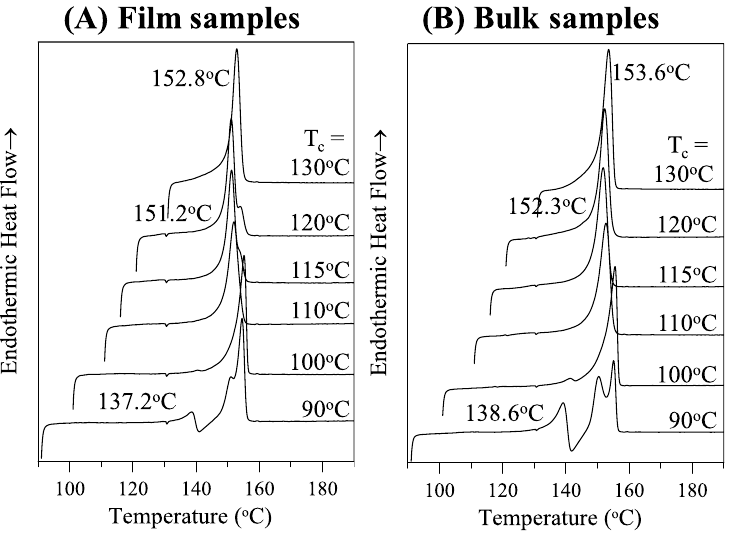
Figure 5. DSC curves of of variously crystallized 11 k-PLLA/240 k-aPMMA (80/20) of ( A ) thin films vs. ( B ) bulk specimens, thermal treatment: 190 °C-2 min-T c .